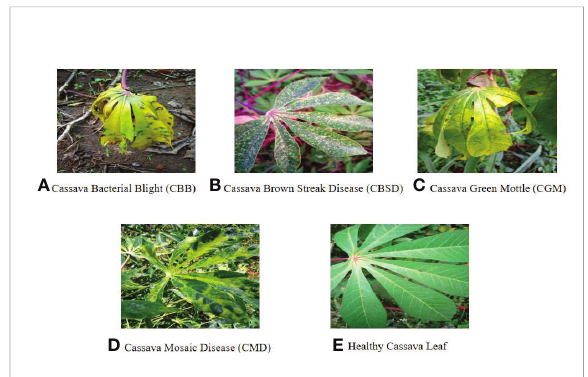
FIGURE 7 Images of cassava leaf diseases ( A – D is the disease of four different cassava leaves and e is the healthy